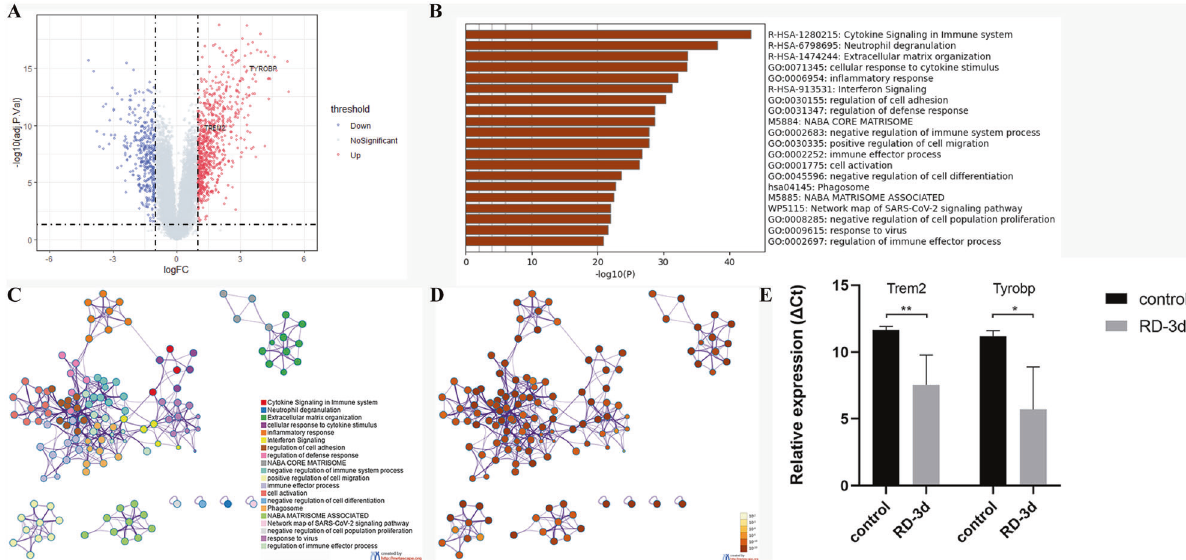
Fig. 6 TREM2 is upregulated after RD. A Volcano plot indicates that TREM2 and its adapter TYROBP are upregulated in the retinal samples of RD patients. B The top 20 GO terms and pathways over-represented by the DEGs in RD patients. C Network of enriched terms colored by cluster ID. D Network of enriched terms colored by p -value. E Relative expression ( Δ Ct) of Trem2 and Tyrobp genes in retina tissues 3 d post-RD. ( n = 4 or more animals in each group). Column heights and error bars indicate mean ± SD. ns, not signi fi cant, * p < 0.05, and ** p < thickness in WT RD model (Fig. 5C). In Trem2 − / − RD mice, the treatment preserved the ONL, and reduced TUNEL + cells at ONL (Fig. 5D). Compared to WT RD retina, the AMD3100 treatment signi fi cantly reduced immune cell in fi ltration, number of TUNEL + cells in the ONL and the thinning of ONL at 3 d post-RD in the Trem2 − / − mice (Fig. 5E, F). Quanti fi cation of TUNEL + and Ly6G + cells in Trem2 − / − RD retina showed simultaneous reduction of both cells after AMD3100 treatment (Additional fi le 2: Fig. S5).